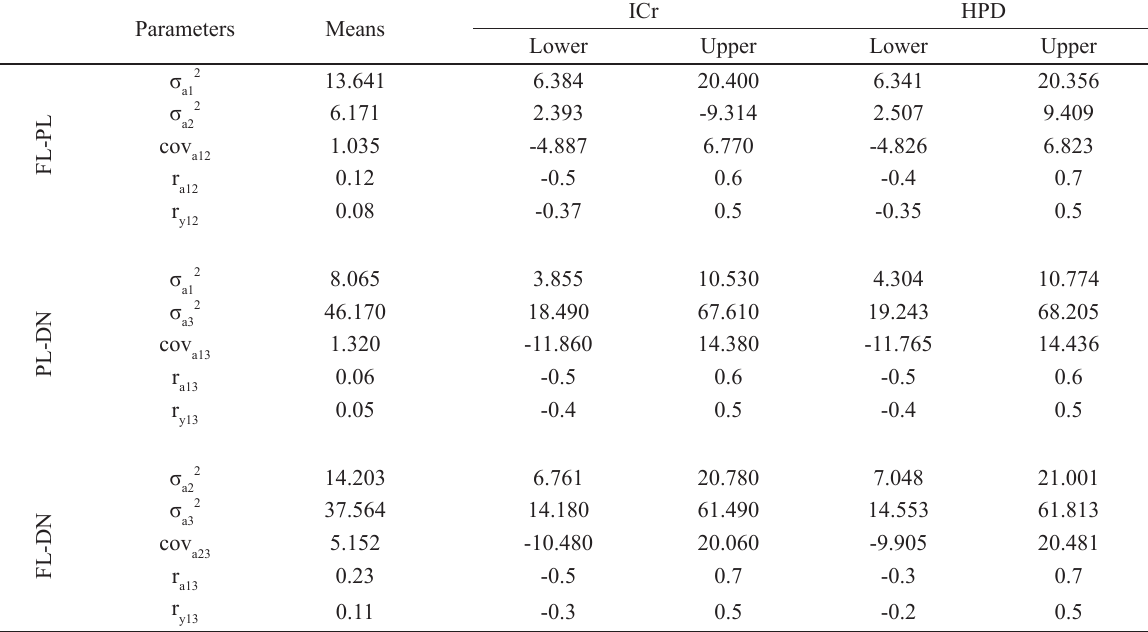
Estimates from bi-characteristic